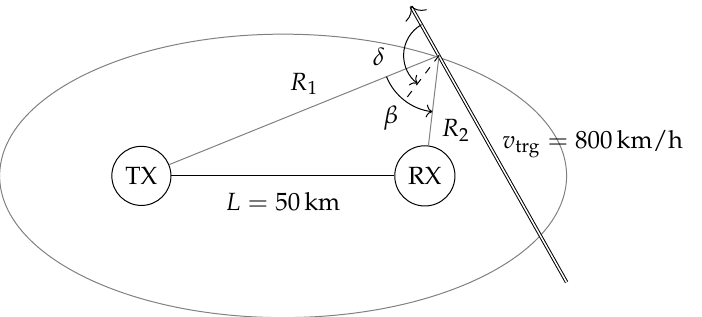
Figure 4. Bistatic setup with a baseline of L = 50km between a transmitter (TX) and receiver (RX) pair with bistatic angle β and a target moving in direction δ at a speed of | (cid:126) v trg | = 800km/h over